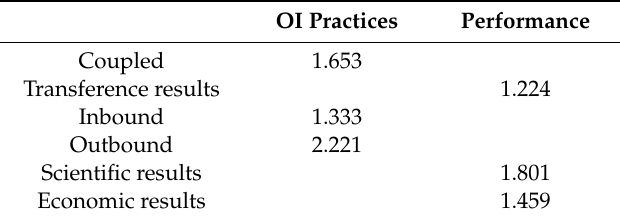
Table 9. Variance inflation factor (VIF) of second order